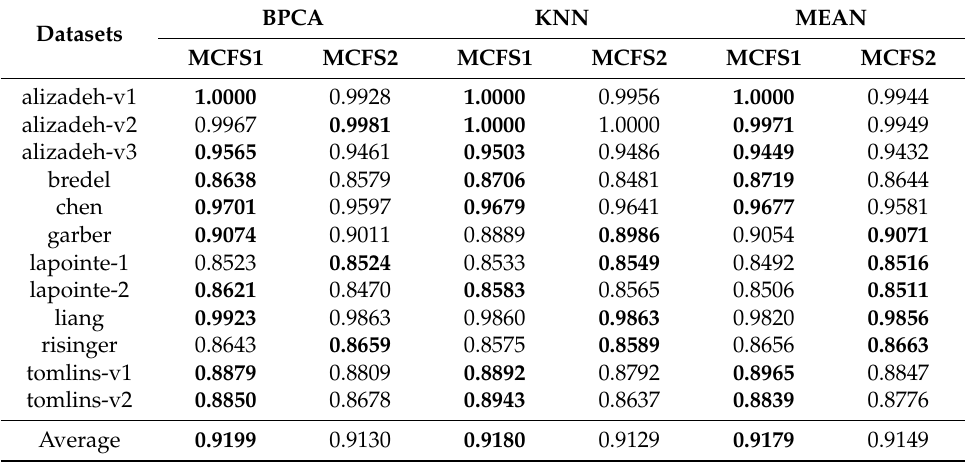
Table 3. Accuracy with beforehand/afterward MCFS under three imputation